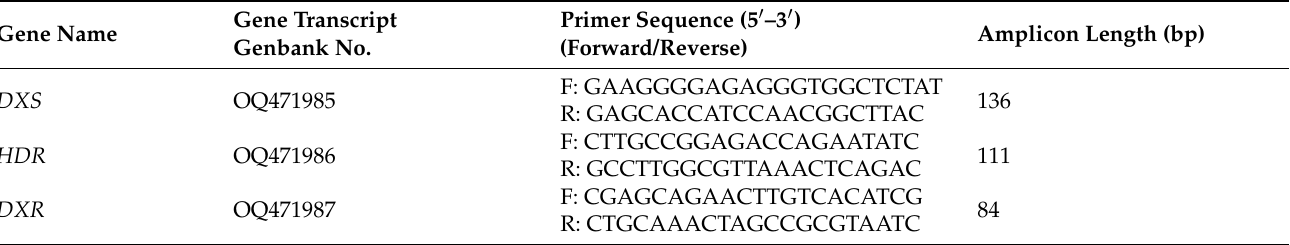
Table 3. Primer sequence information for target genes in L. rotata